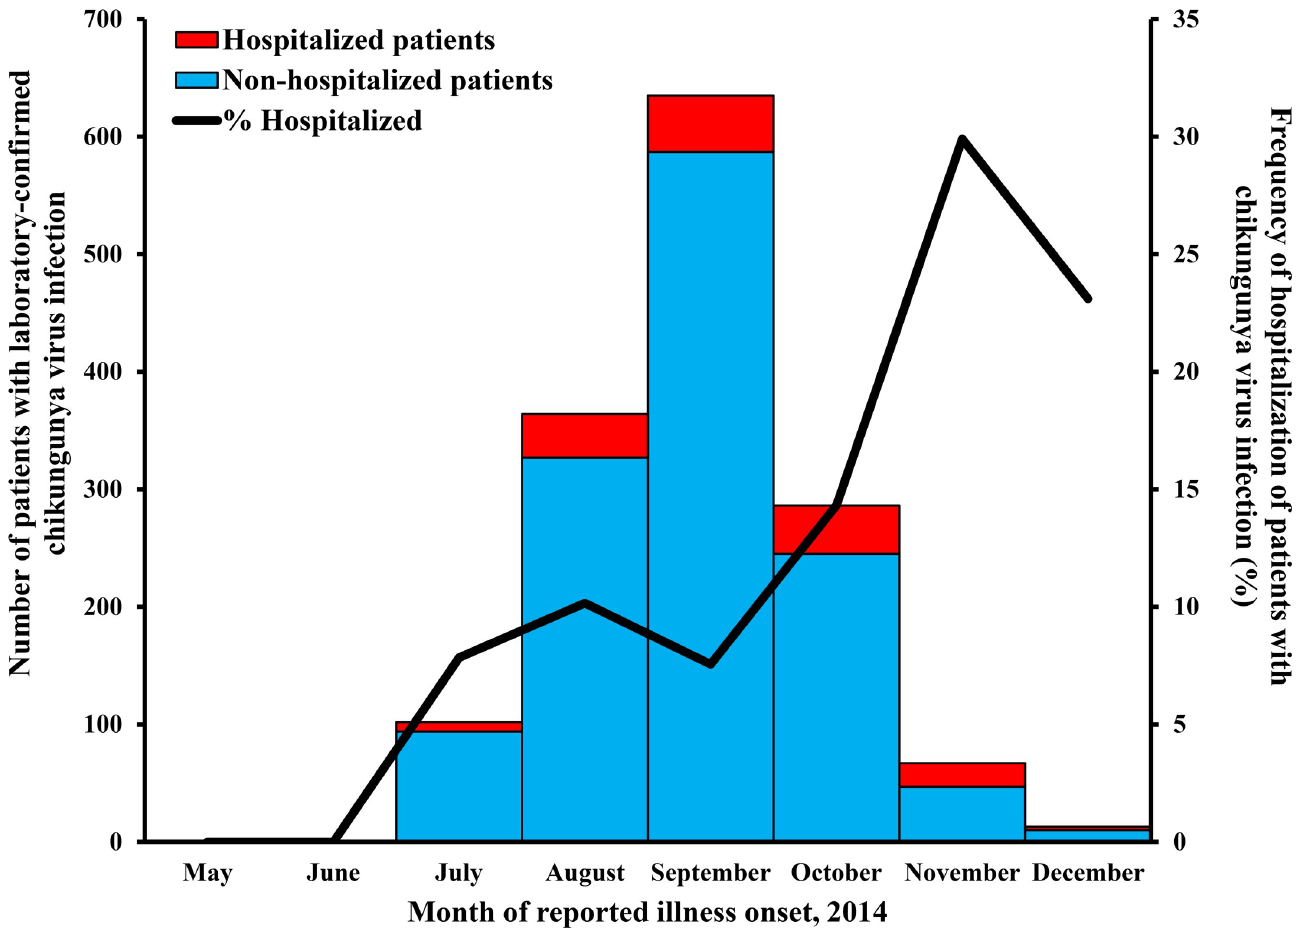
Fig 2. Hospitalized and non-hospitalized chikungunya virus-infected patients enrolled in the Sentinel Enhanced Dengue Surveillance System and frequency of hospitalization by month of illness onset, May–December, 2014.